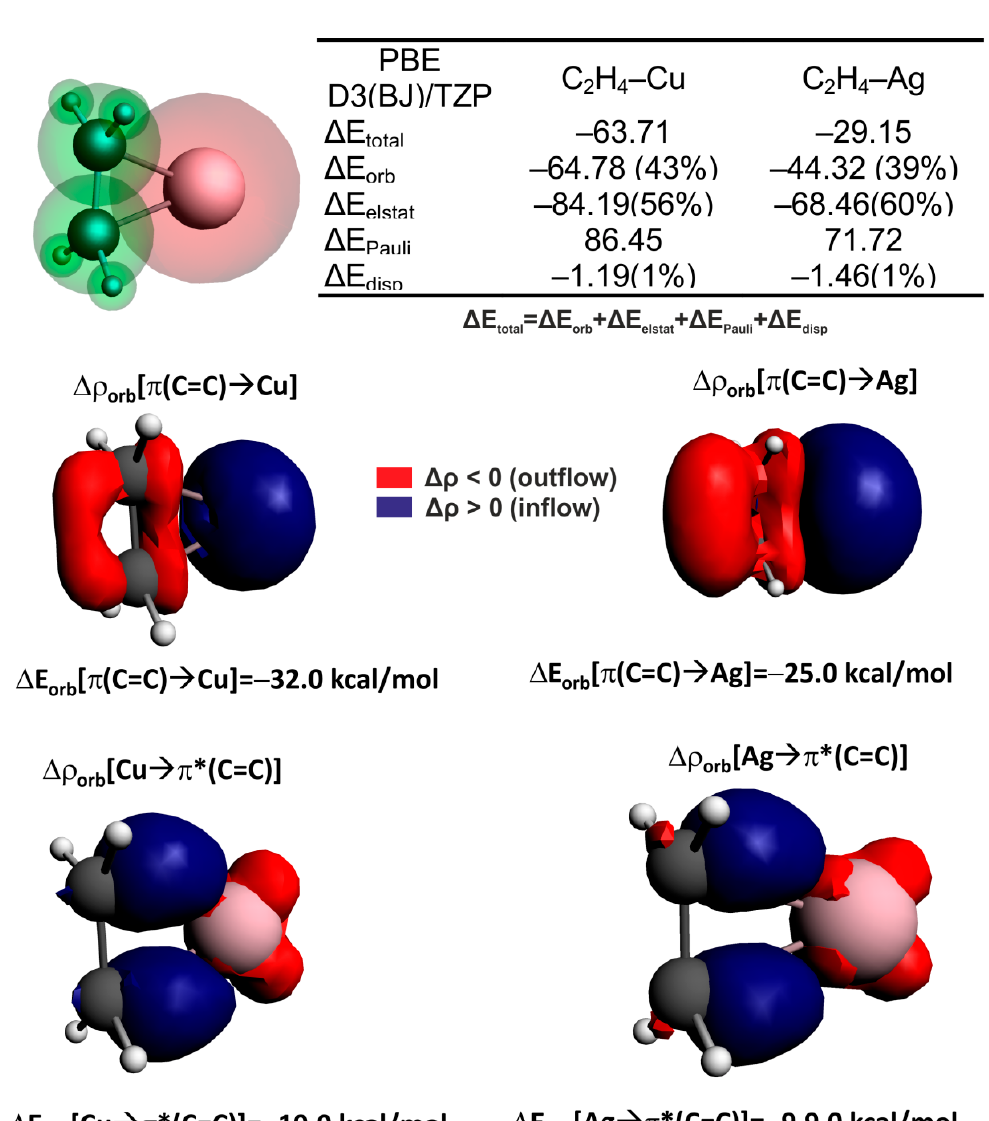
Figure 8. The results of ETS-NOCV/PBE-D3(BJ)/ZORA/TZP energy decomposition describing C 2 H 4 –Cu/Ag bonding. Additionally, the most relevant NOCV-based deformation density channels ∆ ρ orb ( i ), together with their corresponding energies ∆ E orb ( i ), are